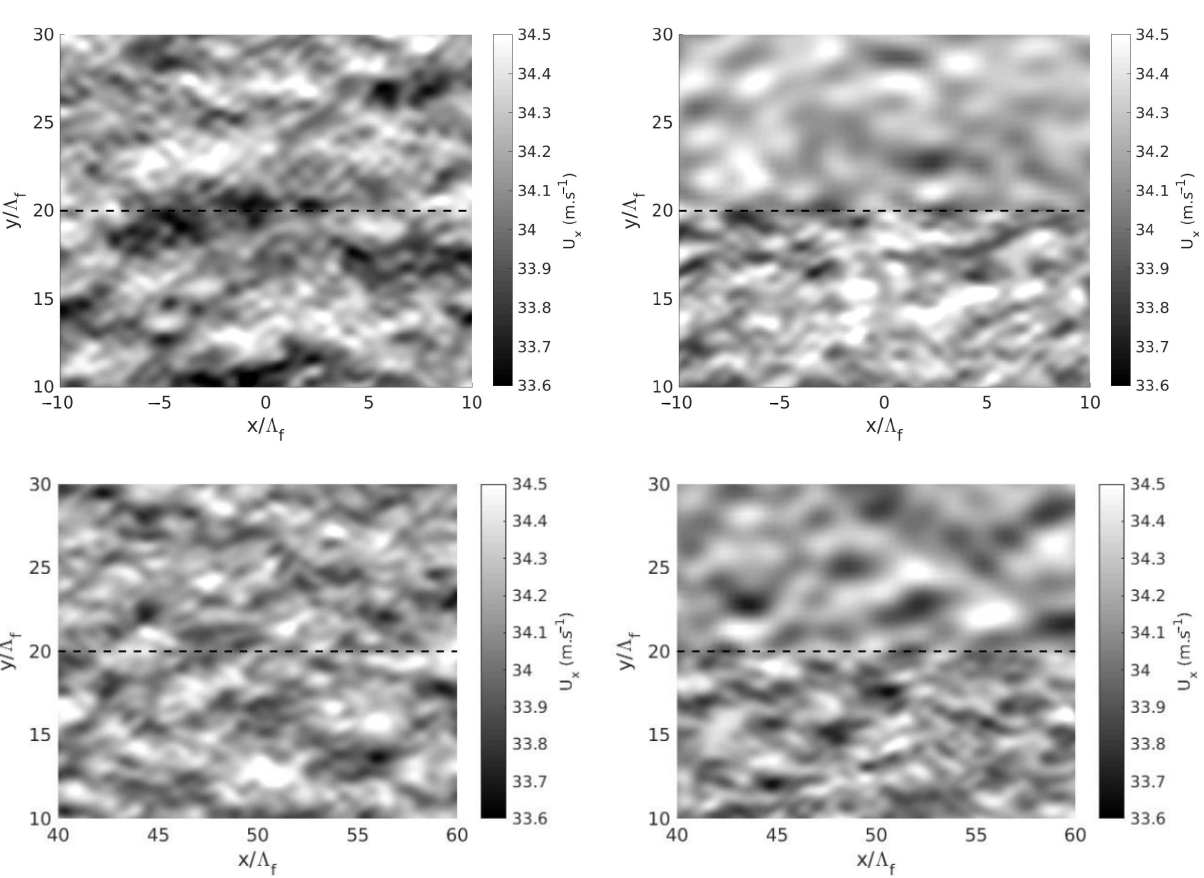
Figure 6. Velocity field along x at the last iteration for a subset of the domain at z = 0. Left column: Single Grid configuration. Right column: Multi Grids configuration. Top plots: RFM simulations. Bottom plots: RFM-P3D